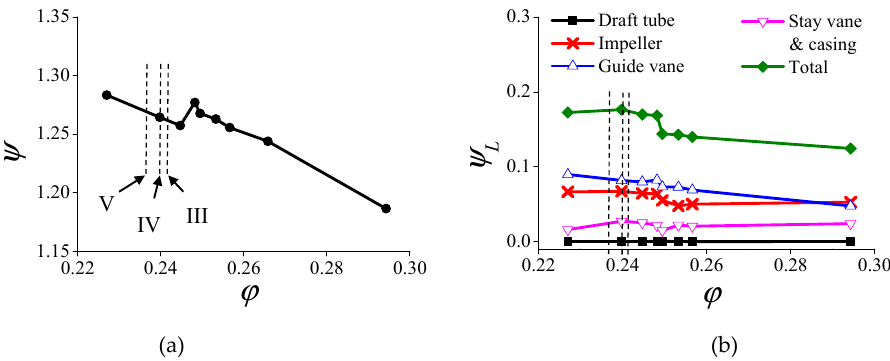
Figure 10. Performance and loss analysis. ( a ) Pump performance curve and ( b ) head loss coefficient in each component.